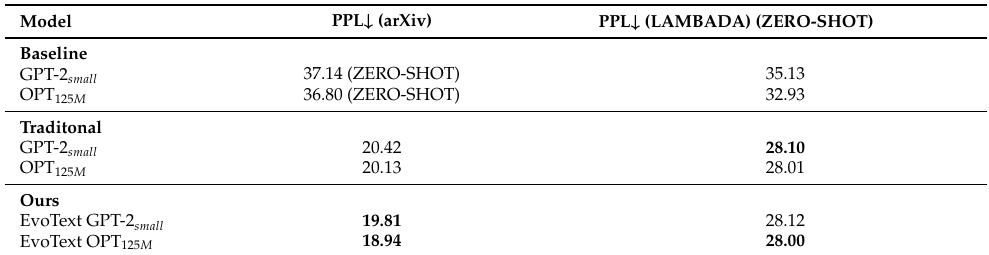
Table 9. We evaluated the performance of both models on the arXiv dataset by retraining the discriminator at a learning rate of 1 × 10 − 4 and the generator at a learning rate of 5 × 10 − 5 . Model PPL ↓ (arXiv) PPL ↓ (LAMBADA) (ZERO-SHOT)